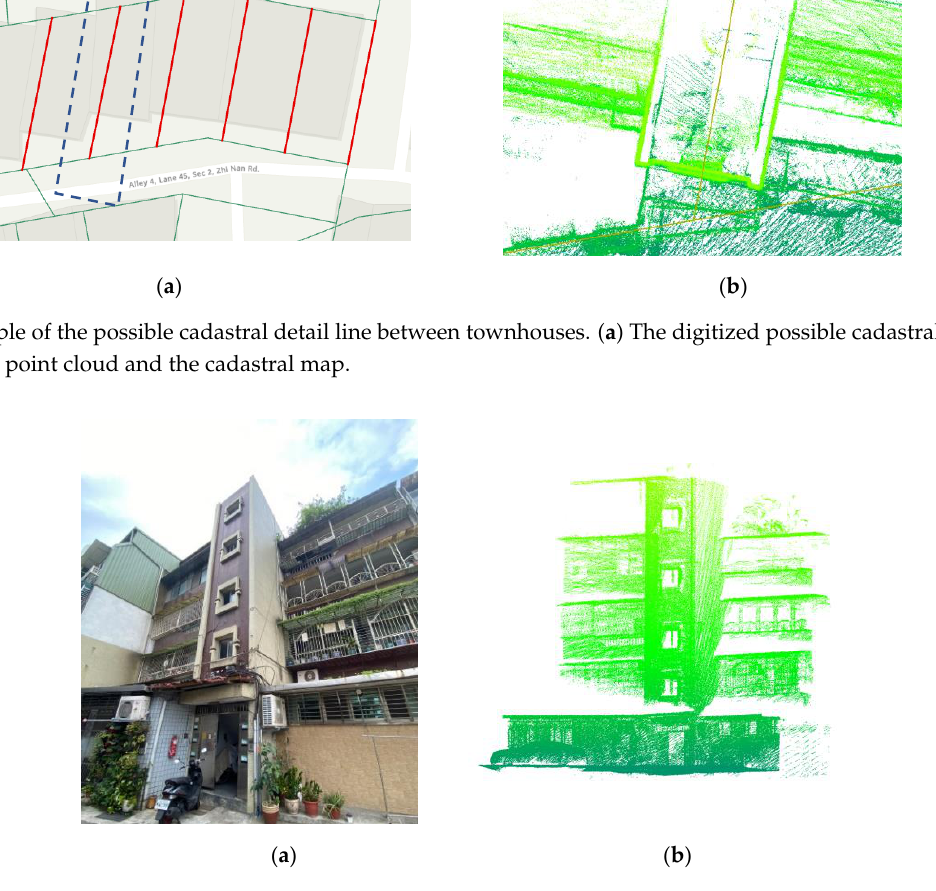
Figure 20. The image of a stairwell and its corresponding point cloud. ( a ) Image of a stairwell. ( b ) Point cloud of a